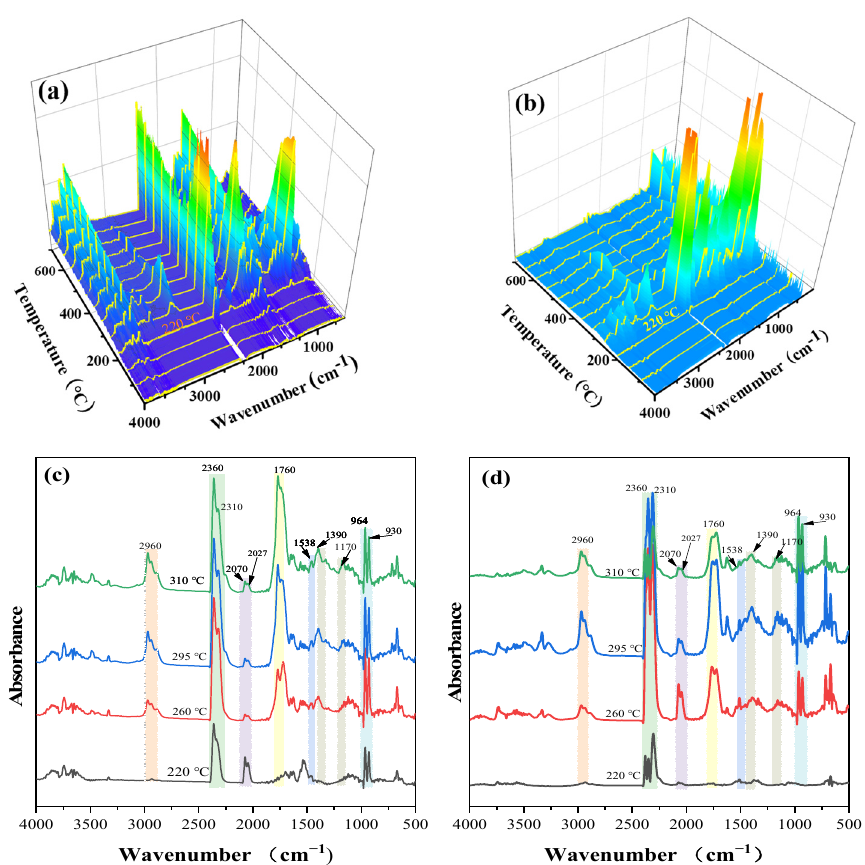
Figure 9. Three-dimensional (3D) TG-FTIR image and IR spectra of the control ( a , c ) and PBTCA-treated wool ( b , d ). By comparing the 3D image and spectra of the control wool to that of the treated, it can be seen that similar volatile species were released from the two wool samples during the decomposition process. The bands at the range of 2830–3240 cm − 1 correspond to the hydrocarbon volatiles [51]. The peaks at 2360 cm − 1 and 2310 cm − 1 are attributed to CO 2 , the peaks that appeared at 2070 cm − 1 and 2027 cm − 1 are ascribed to the absorption of CO, the peak at 1538 cm − 1 is ascribed to the volatility of H 2 S, the peaks at 1390 cm − 1 and 1170 cm − 1 are attributed to the SO 2 , and the peaks at 964 cm − 1 and 930 cm − 1 are attributed to the NH 3 .